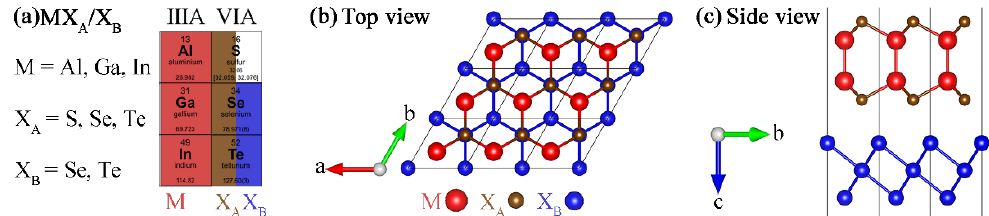
Figure 1. ( a ) Position in periodic table of elements for MX A /X B (M = Al, Ga, In, X A = S, Se, Te and X B = Se, Te) heterostructures. ( b ) top- and ( c ) side-views of optimized structure of MX A /X B heterostructures.